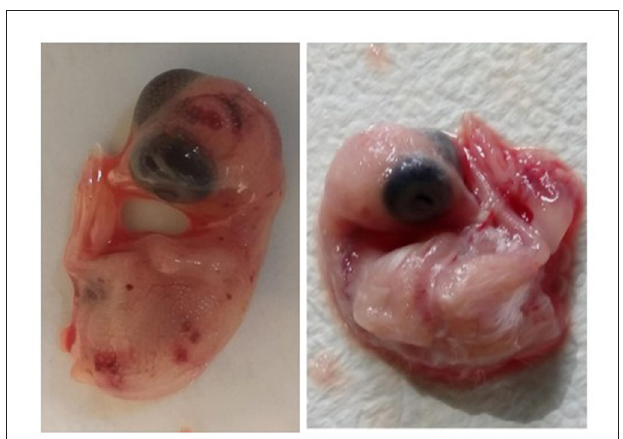
TABLE 5 | Identification of CAstV and ANV on location of chicken flocks. FIGURE 2 | The hemorrhagic, edematous chicken embryos with gelatinous lesions and dwarfism due to growth of virus after inoculation of virus through yolk sac route (left image) and non-infected chicken embryo (right image).